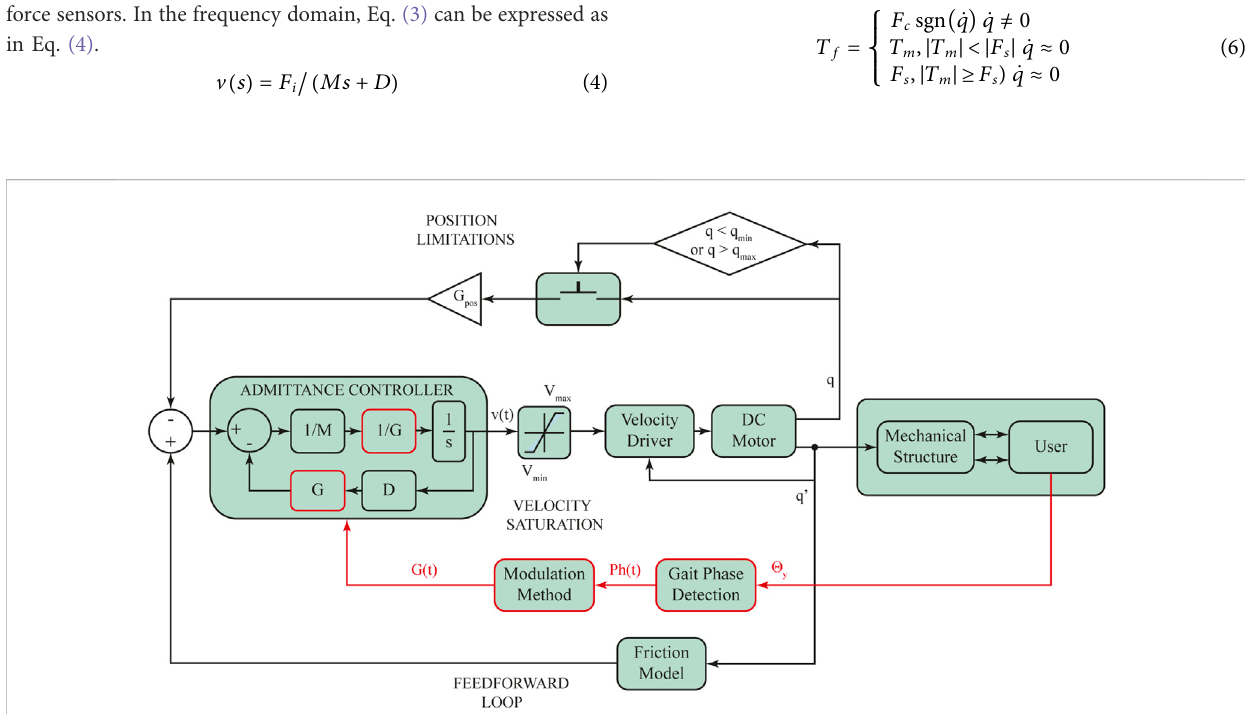
FIGURE 7 Stance control strategy implemented in the AGoRA exoskeleton. This control approach takes into account the human-robot interaction forces to render limitedvelocity pro fi lesaccordingly.Additionalpositionlimitations areincluded forthesakeofsafety. Θ y :Angularvelocityalongthesagittal plane. Ph ( t ): Current detected gait phase as a function of time.